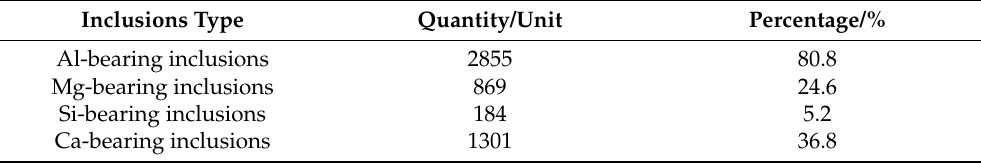
Table 9. Quantities of inclusions with different compositions within a 100 mm 2 region of sample 1#.